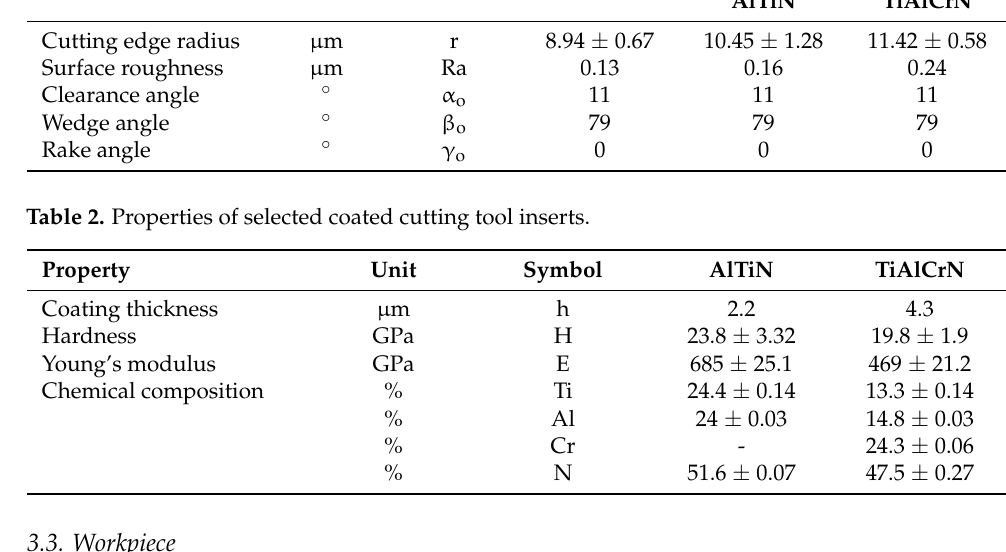
Figure 6. General scheme of central composite planning for two factors. Factor A (no unit parameter) is characterised by the feed per revolutions (f n ), and factor B (no unit parameter) is characterised by the cutting speed (v c ). The cutting conditions for the different levels of the central composite planning of the experiments are shown in Table 3, where α was set to 1.41421 by Minitab (Version: 20.1.1, Minitab Ltd., Coventry, UK). Table 3. Cutting conditions for the different levels of the central composite planning. Parameter